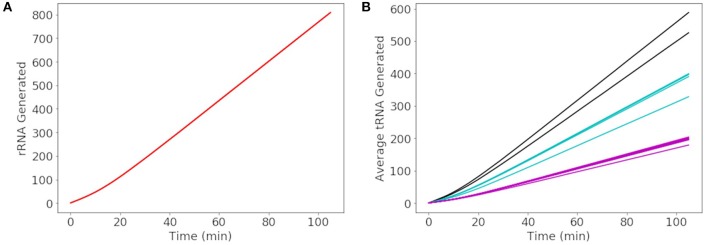
Generated abundances of rRNA and tRNA for a cell cycle averaged over 1000 replicates. (A) 16S, 23S, and 5S rRNA are each generated to the same average abundance of 800 over a cell cycle. (B) The average abundance of each tRNA generated in a cell cycle results in a total abundance of approximately 4000 tRNAs. The tRNAs in black are methionine and leucine, in blue are threonine, tryptophan, lysine, arginine, and serine, and remaining tRNAs are shown in pink.